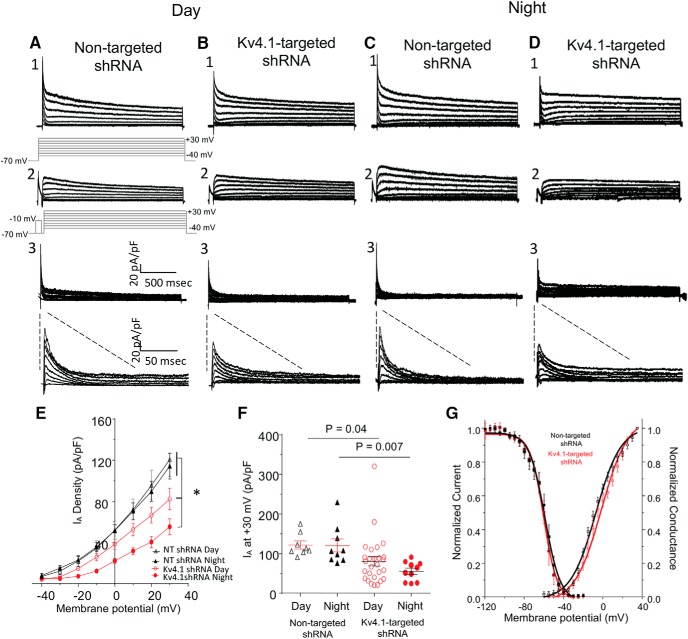
Acute knockdown of Kv4.1 decreases A-type K+ currents (IA) in SCN neurons during the day and at night. A–D, Representative whole-cell Kv current recordings, obtained during the day (ZT7–ZT12) or at night (ZT19–ZT24) from eGFP-positive SCN neurons in acute slices prepared from adult animals 14–30 d following injections of the nontargeted shRNA-expressing (A, C) or the Kv4.1-targeted shRNA-expressing (B, D) AAV8, are shown. Whole-cell Kv currents, evoked during (2 s) voltage steps to potentials ranging from −40 to +30 mV (in 10-mV increments) from a holding potential of −70 mV, were recorded from nontargeted shRNA- and Kv4.1-targeted shRNA-expressing SCN neurons during the day (A1–B1) and at night (C1–D1). A second voltage-clamp paradigm, that included a brief (60 ms) prepulse to −10 mV to inactivate IA, was then presented, and whole-cell Kv currents in each cell were recorded again (A2–D2). The voltage-clamp paradigms are illustrated (light gray) below the current records. Digital offline subtraction of the recordings with the prepulse (A2–D2) from those without the prepulse (A1–D1) isolated IA (A3–D3); the subtracted records are also shown on an expanded time scale. E, IA densities at each test potential in each cell were calculated and mean ± SEM values are plotted as a function of test potential. F, Mean ± SEM IA densities at +30 mV were significantly lower in Kv4.1-targeted shRNA-expressing (n = 10–27), than in nontargeted shRNA-expressing (n = 8–10) SCN neurons during the day and at night; p values (one-way ANOVA) are indicated. G, The activation curves for Kv4.1-targeted shRNA-expressing SCN neurons (open red squares, n = 8) and nontargeted shRNA-expressing SCN neurons (open black squares, n = 12) are not significantly (p = 0.052, Student’s t test) different (V1/2 = −1.8 ± 3.2 mV, k = 13.5 ± 1.1 and −9.3 mV ± 1.3 mV, k = 12.7 ± 0.8, respectively). The inactivation curves plotted as the mean ± SEM normalized current for Kv4.1-targeted shRNA-expressing (filled red squares, n = 8) and nontargeted shRNA-expressing (filled black squares, n = 12) SCN neurons are also shown. The inactivation curve for Kv4.1-targeted shRNA-expressing SCN neurons (V1/2 = −60.3 mV ± 1.7 mV and k = 7.0 ± 0.6) is not significantly (p > 0.05, Student’s t test) different from the nontargeted shRNA-expressing SCN neurons (V1/2 = −59.4 mV ± 2.1 mV and k = 7.9 ± 0.7).